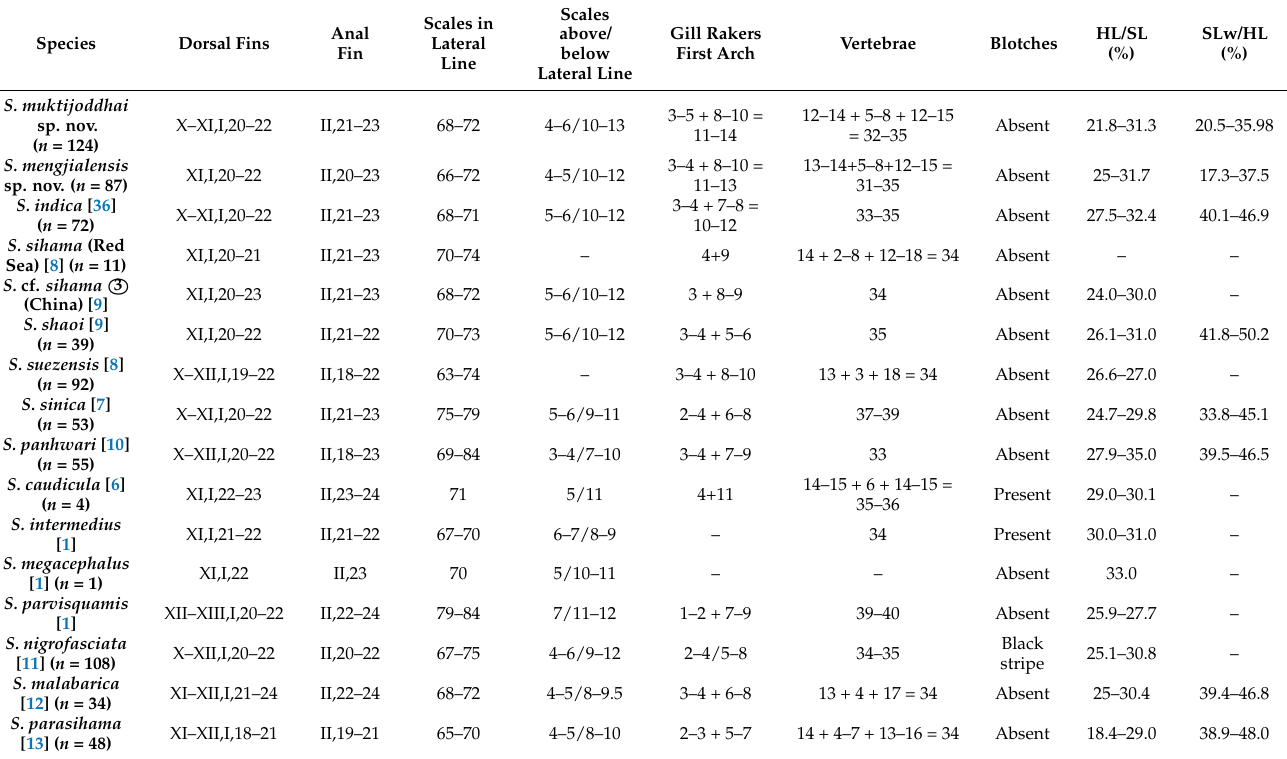
Table 2. Comparison of S . muktijoddhai sp. nov. and S . mengjialensis sp. nov. and 14 other species of Sillago with two posterior extensions of the